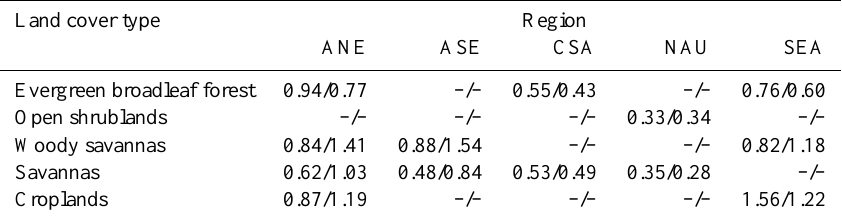
Table 3. Mean gradients (FERs), in gNO x s − 1 MW − 1 , derived from the best fitting least-squares regression lines for each land cover type and the selected regions, applying the morning (left) and early afternoon (right) linear relationships between P f and FRP. Land cover